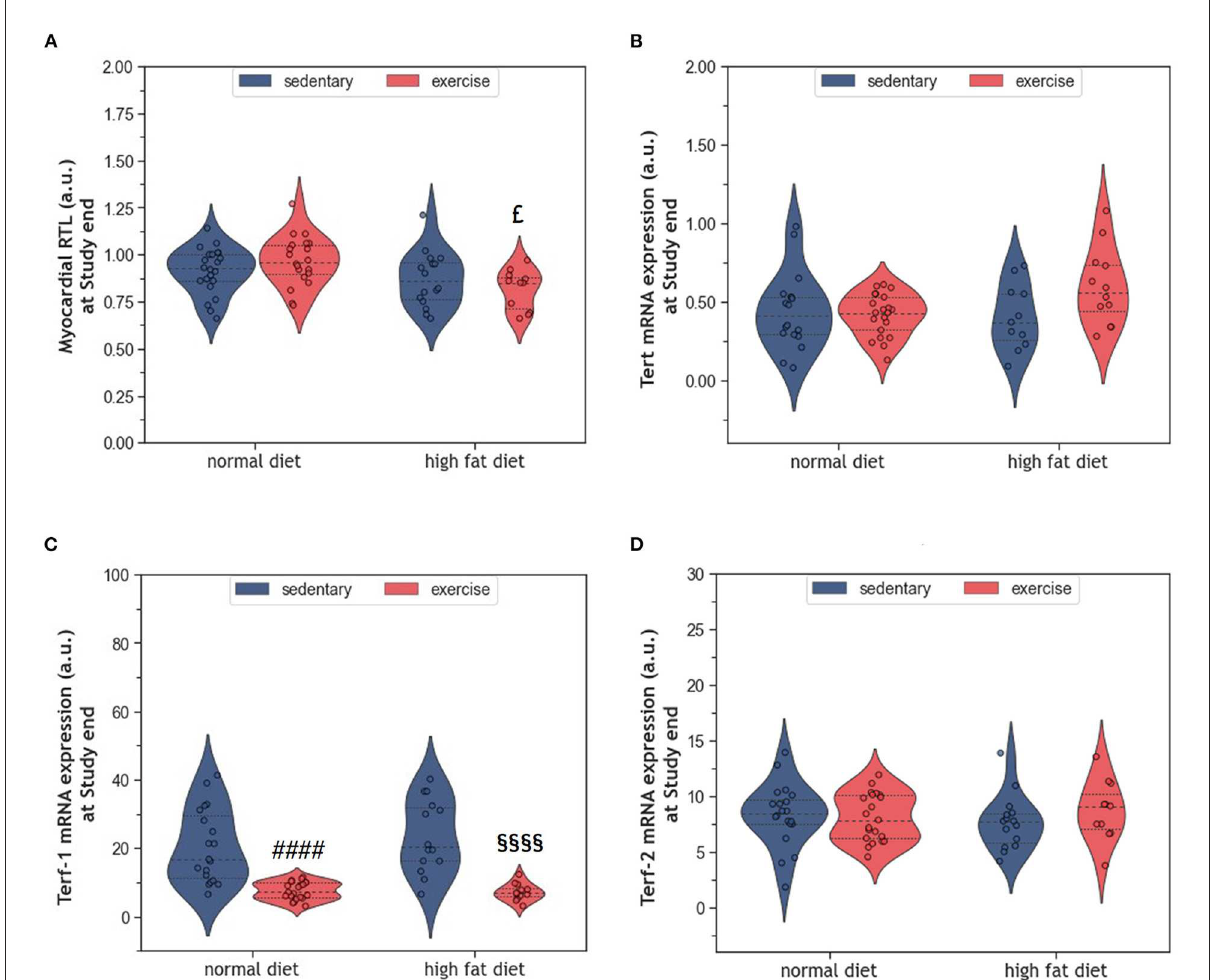
FIGURE7 (A) Violin plot showing the myocardial RTL. (B) Violin plot showing the Tert mRNA gene expression. (C, D) Violin plot showing the Terf-1 and Terf-2 mRNA gene expression; the dashed line represents the group median whereas the dotted lines show the 25th − 75th interquartile range. The circles indicate the scatter of the data. Group differences have been calculated in (A–C) by the two-way ANOVA with Sidak post-hoc tests for multiple comparisons; whereas in (D) with the Mann-Whitney U -test. £ p = 0.017 compared to the exercise normal diet control